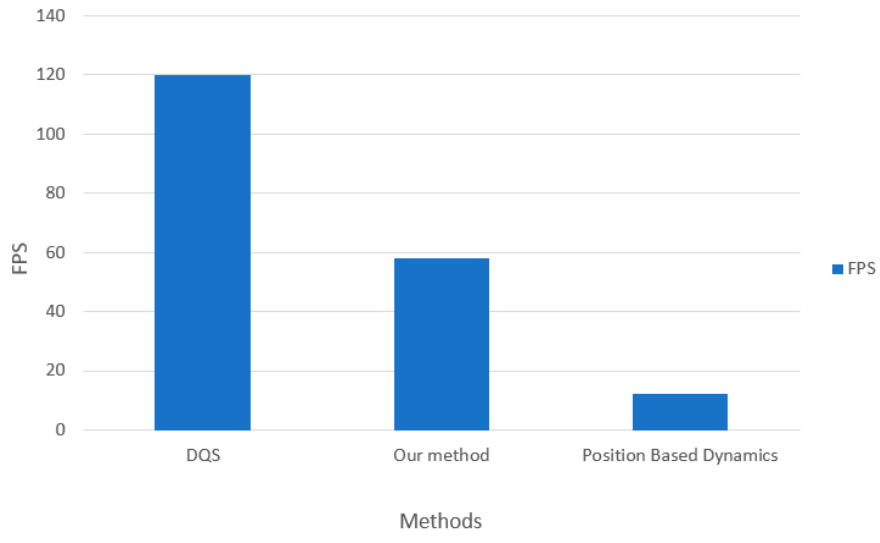
Figure 5. Comparison of frame rates between proposed and conventional methods.